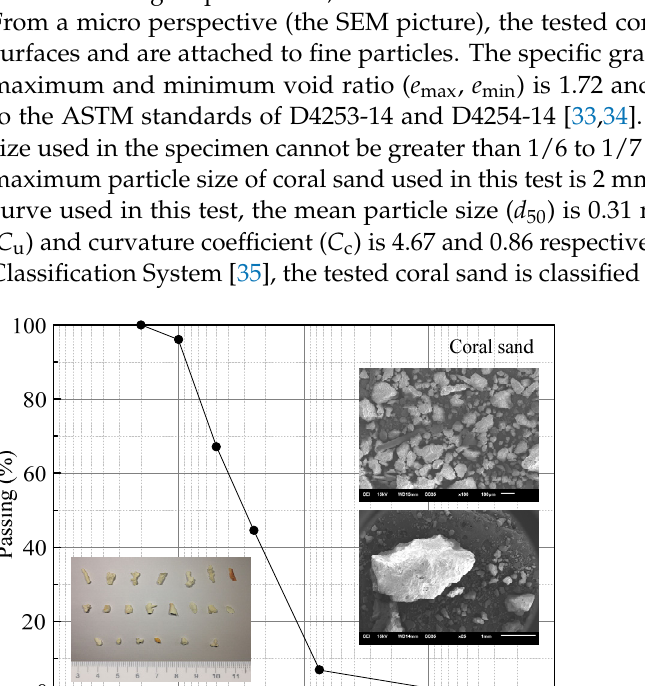
(c) (d) o rH (a) Figure 2. Hollow cylinder apparatus and illustrative stress state in a hollow cylindrical specimen subjected to axial load W , torque M T , inner pressure p i , and outer pressure p o : ( a ) applied loads, ( b ) stress components, ( c ) principal stress components, and ( d ) major, intermediate, minor principal stress. Table 1. Performance indexes of the apparatus used in this study. Controller